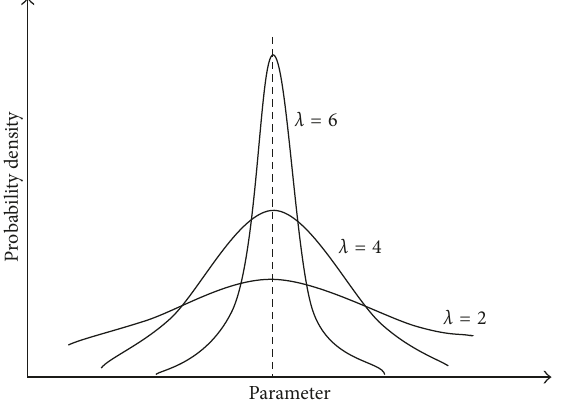
Figure 5: The distribution of mechanical parameters of various homogeneity indexes.